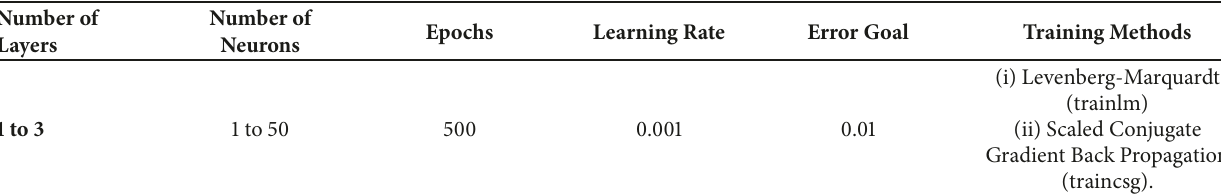
Table 1: MNN data.